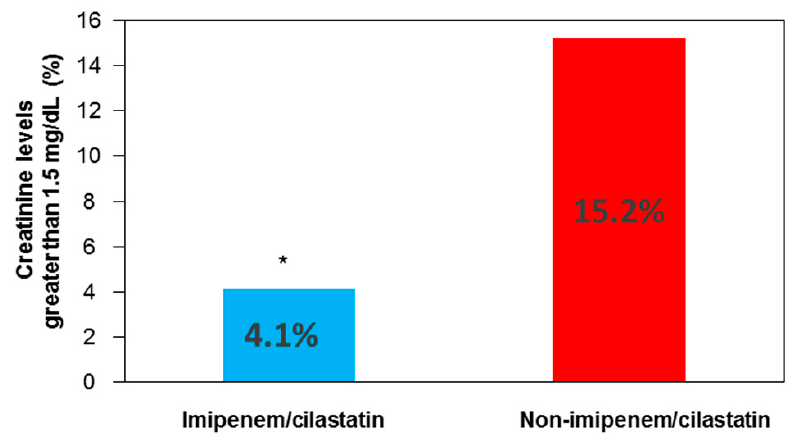
Figure 4. Percentage of patients with creatinine levels above 1.5 mg/dL on day 4 of the postoperative period in both groups. * p = 0.024 vs. the non-imipenem/cilastatin group.